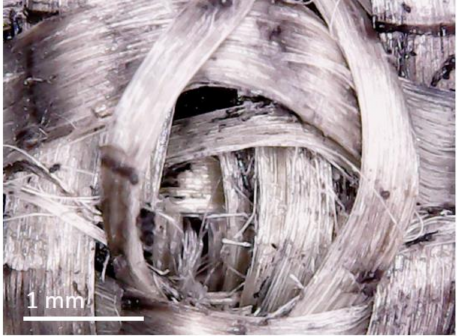
Figure 7. Magnification of penetration